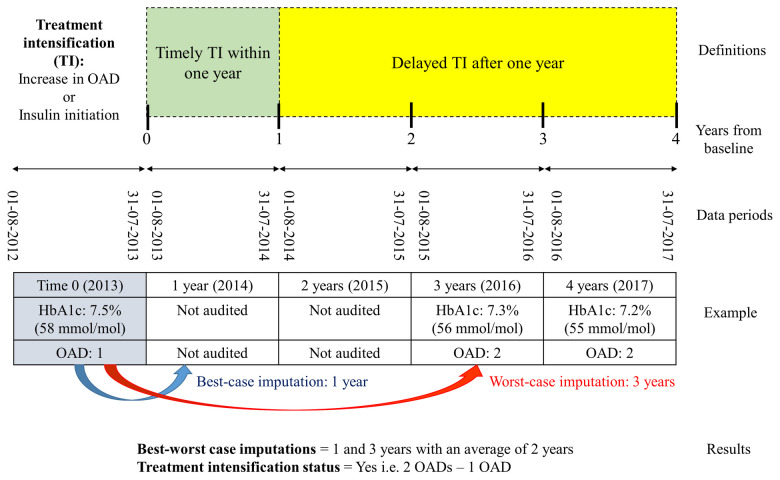
Definitions and an example using best- and worst-case scenario analysis.